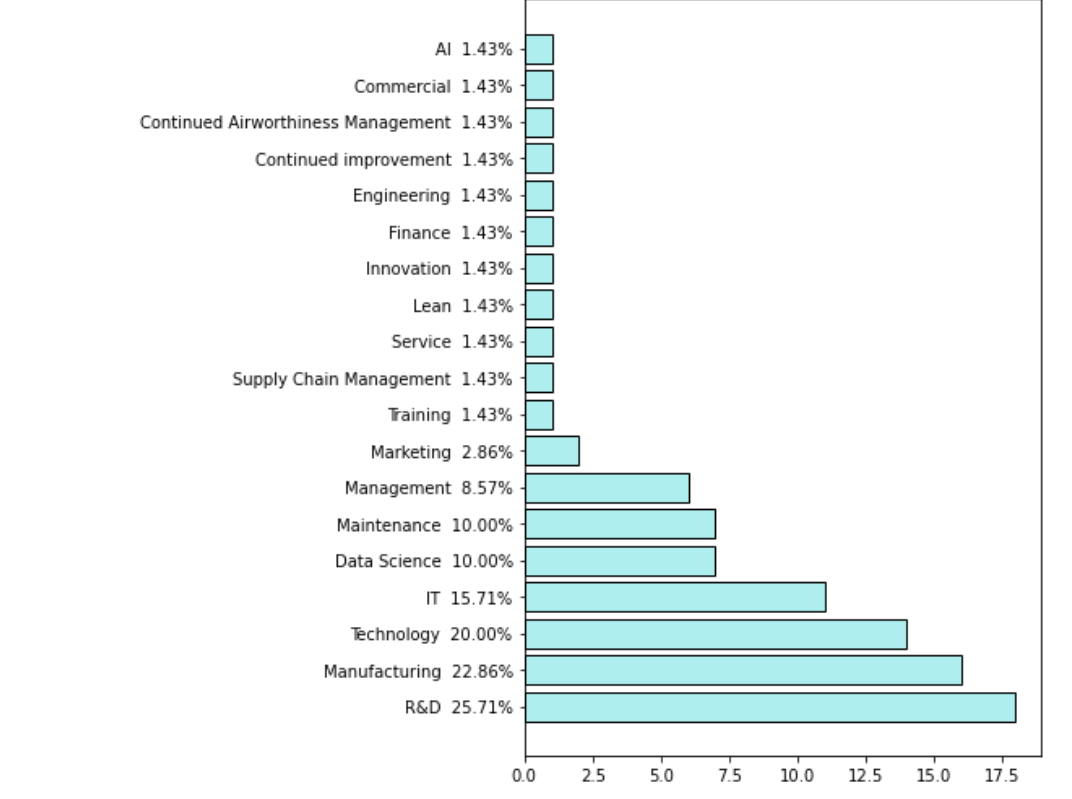
Figure 8. Departments represented by employees taking part in the research.